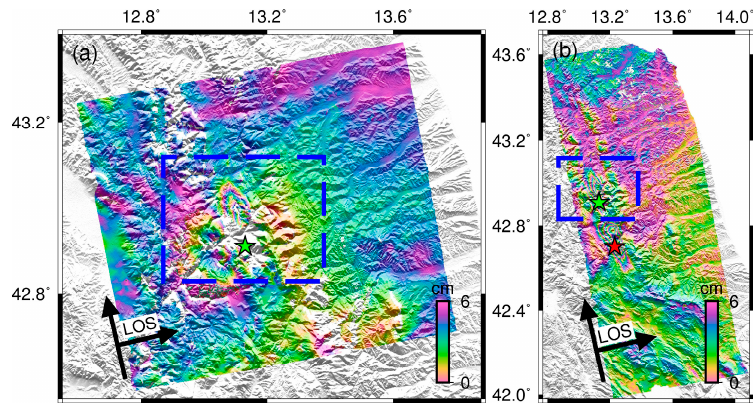
Figure 4. Coseismic interferograms of 26 October 2016 Visso earthquake obtained from the ascending Sentinel-1 track T044 ( a ), the ascending ALOS-2 track P197A ( b ). The interferogram are rewrapped with an interval of 6 cm. The red star corresponds to the epicenter of 24 August 2016 Amatrice earthquake [12]. The green star corresponds to the epicenter of 26 October 2016 Visso earthquake [12]. The blue rectangle outlines the study area.